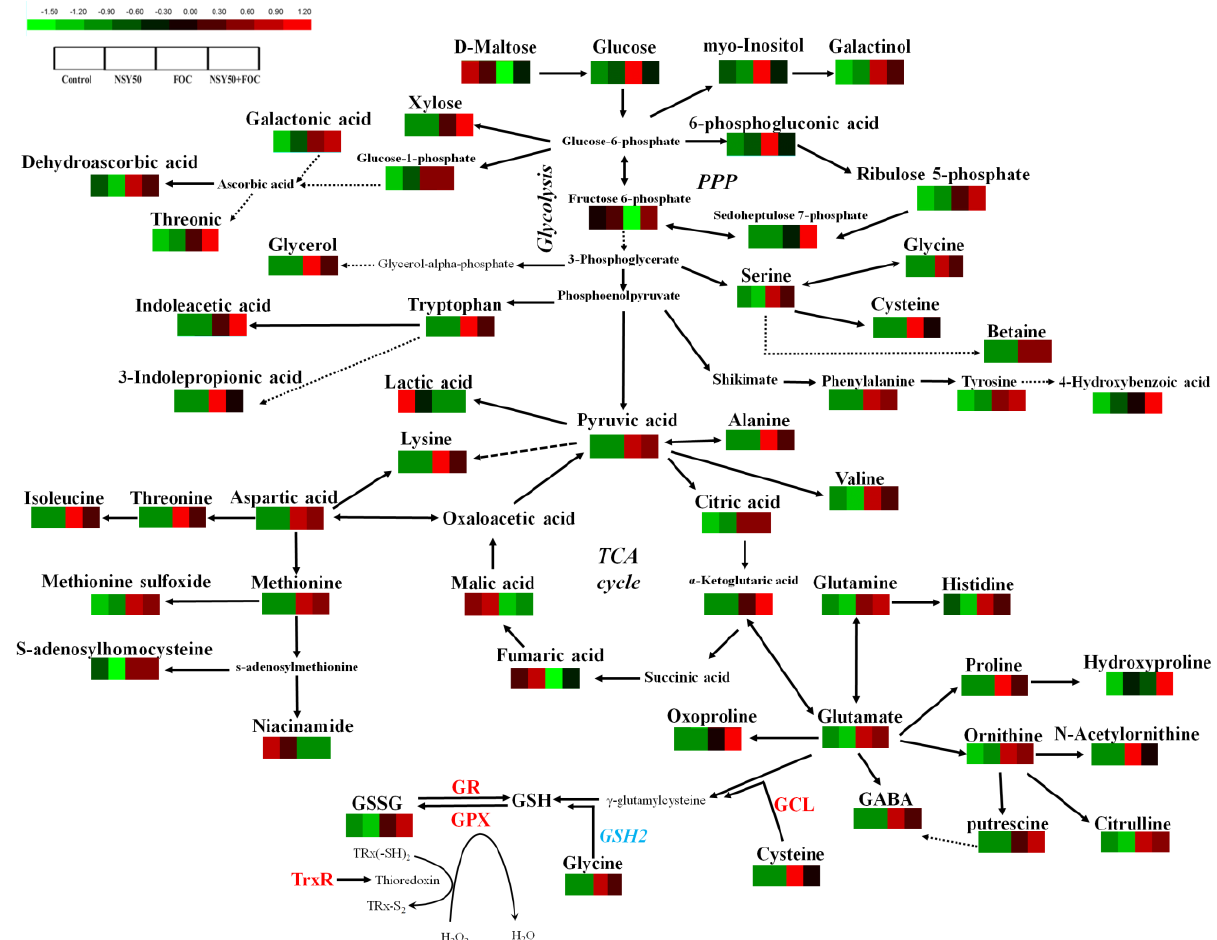
Figure 7. Visualization of the metabolite changes and related pathways in P. polymyxa NSY50 treated cucumber plants (NSY50), NSY50-pretreated cucumber plants challenged with FOC strain (NSY50 + FOC), FOC treated cucumber plants (FOC), and sterile distilled water-treated control (Control). All of the metabolites based on relative peak area in the control and strains NSY50 and FOC-applied cucumber roots. Green (low) to red (high) represents the increase in relative area of each peak among the four treatments. This figure corresponds to Table S2. Significant difference at p < 0.05. Abbreviations: GCL, γ -glutamylcysteine synthase; GR, Glutathione reductase; GPX, glutathione peroxidase; TrxR, thioredoxin